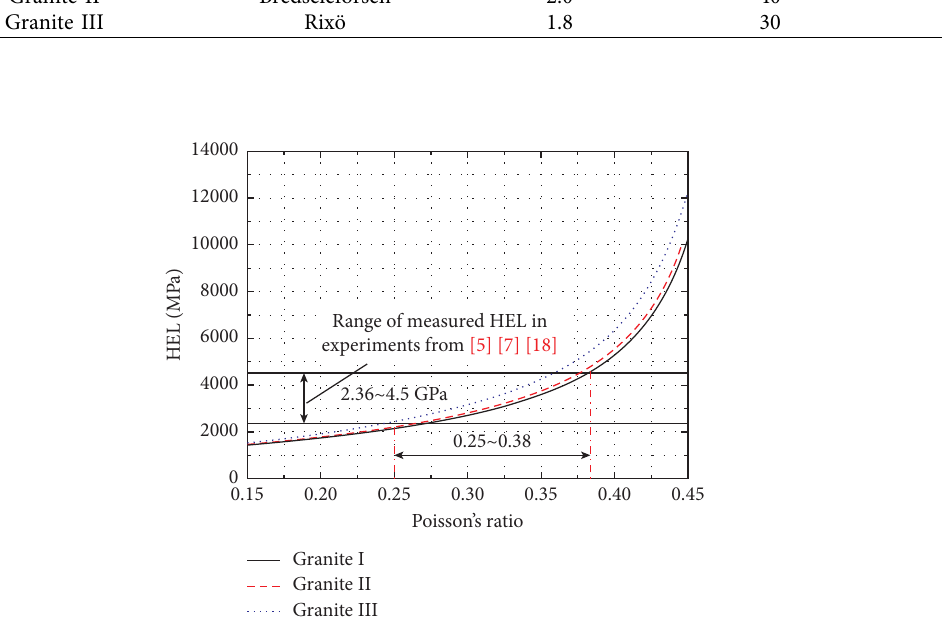
� 2, τ � 1GPa). (b) HEL vs. μ ] � 0.3, μ s d